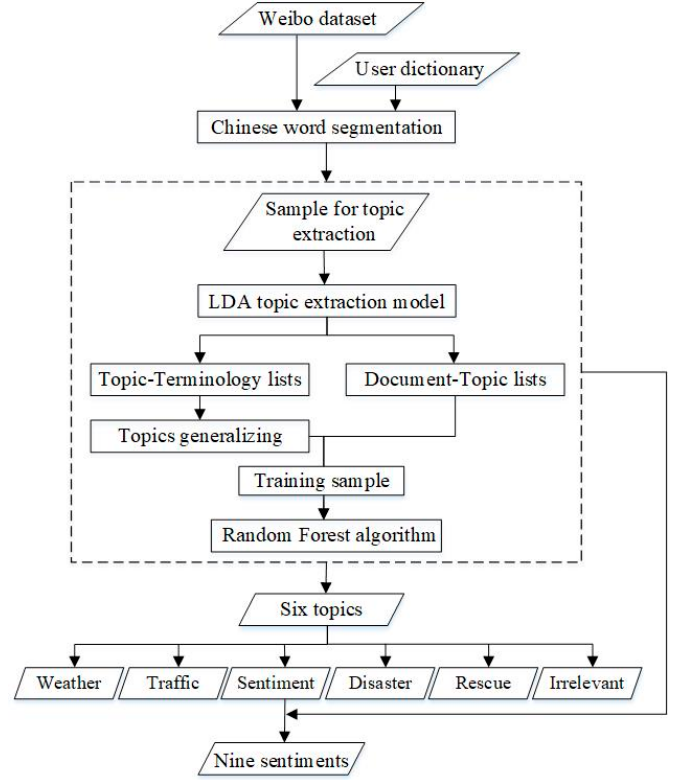
Figure 2. The processes of the topic extraction and classification model.